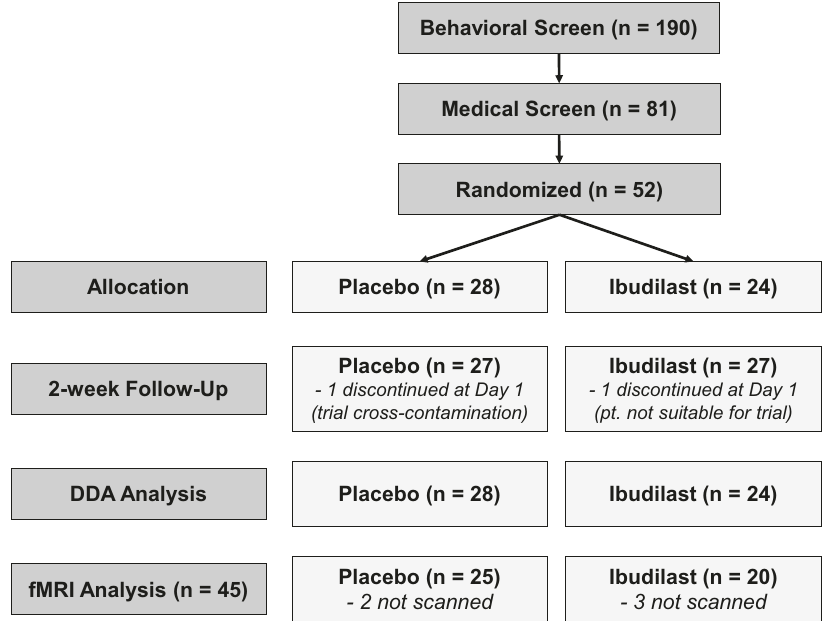
Fig. 1 Subject fl ow diagram. CONSORT diagram of subject fl ow through the